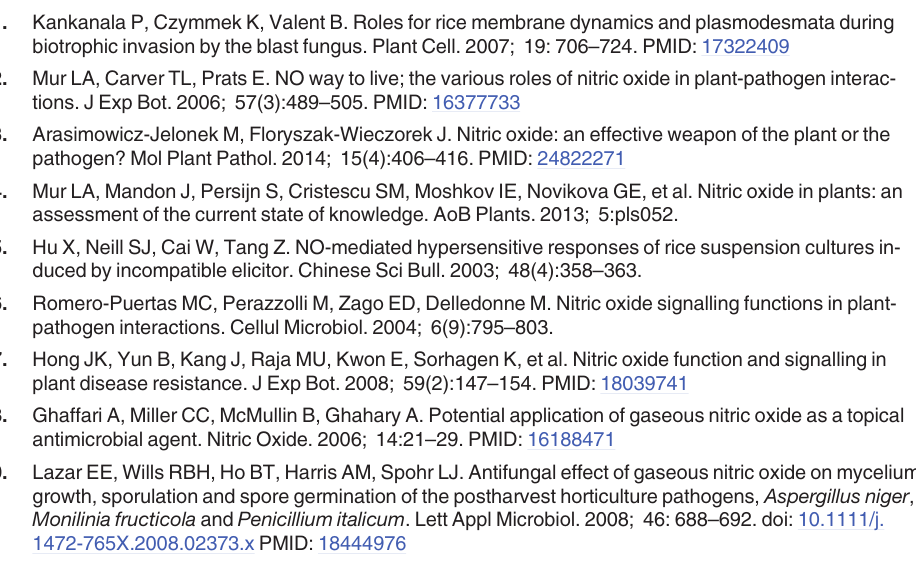
S4 Fig. The rates of spore germination and appressoria formation in the tested M . oryzae strains. The rates of germination and appressoria formation were evaluated at 28°C after 24 hpi, and > 200 conidia of each strain were observed for each strain. The experiments were repli- cated three times. Blank bar for germination rate. Grey bar for appressoria formation rate. (TIF) S5 Fig. The expression of rice pathogenesis-related (PR) genes after chanllege inoculation with M . oryzae strains. Four-week-old seedlings of rice ( O . sativa cv CO-39) were inoculated with suspensions of M . oryzae conidia prepared in 0.25% gelatin at a concentration of 5×10 4 conidia ml − 1 using an artist's airbrush with high-pressure air. Rice leaves were sampled at 24, 48, and 72 hpi. The relative expression levels of PR1a , PR4 , PR5 , and PR10a in the infected rice was compared using quantitative RT-PCR. Normalization of average threshold cycle (Ct) was performed with that of O . sativa elongation factor 1 α gene. Primers were synthesized according to Hao et al. (Plant Physiol Biochem. 2012; 60:150 – 156).